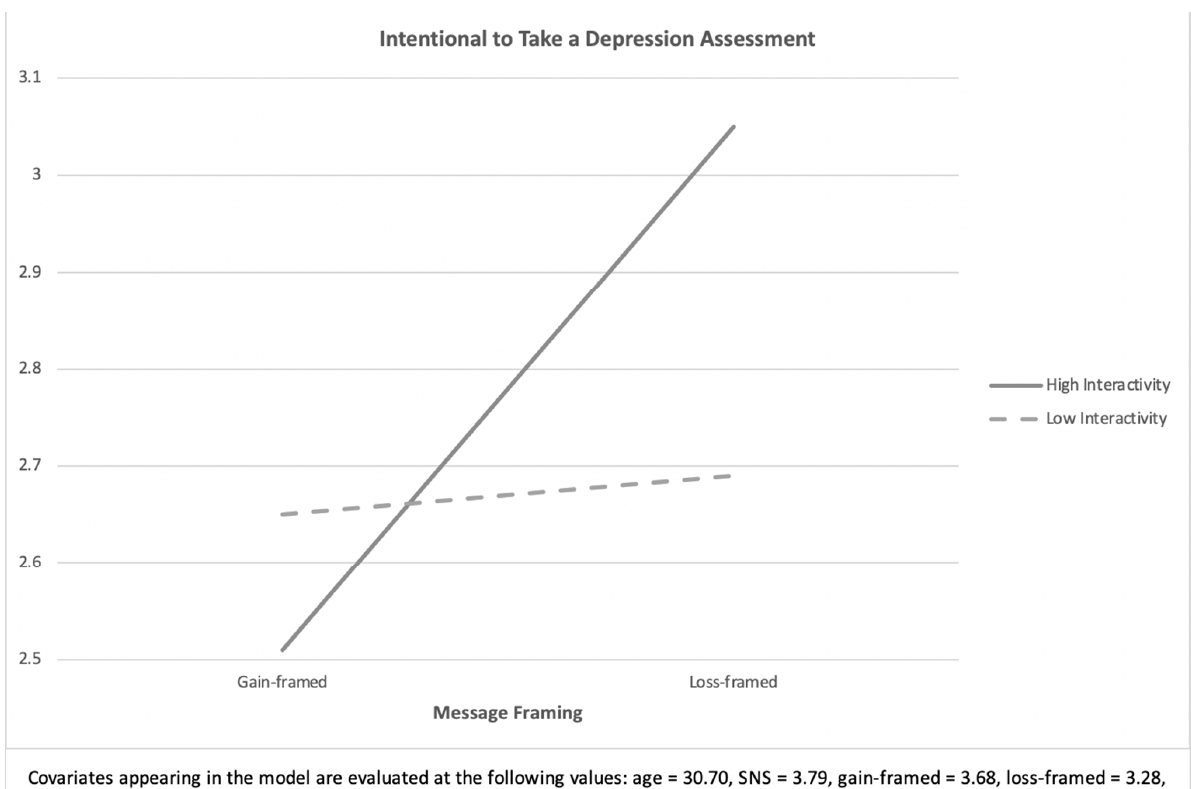
Figure 3. Interaction effect of framed messages and interactivity of social media (H2).